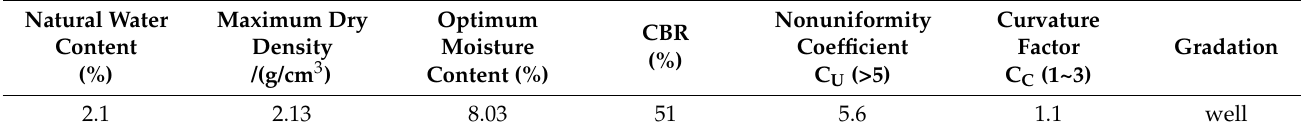
Table 2. Basic performance indicators of soil